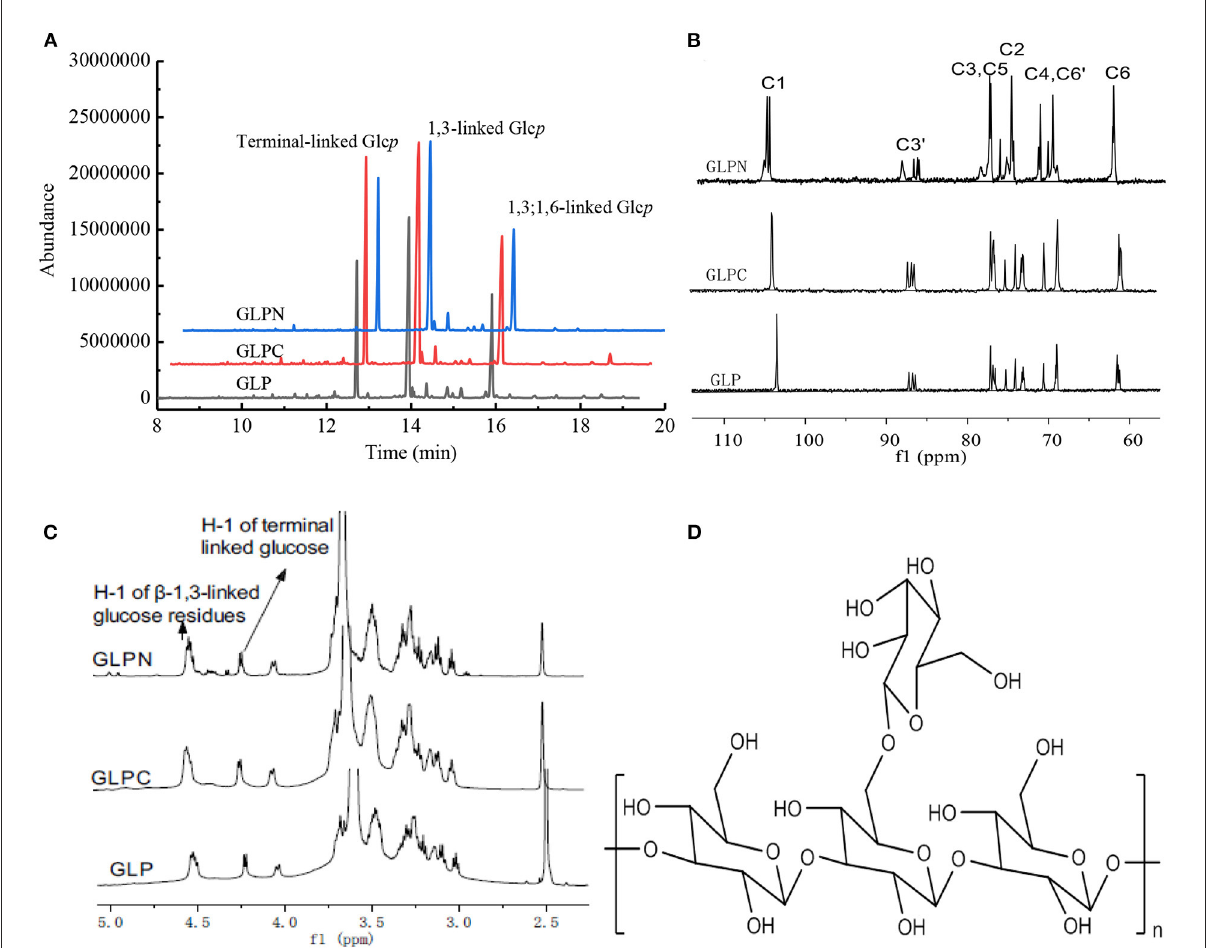
FIGURE3 Structure analysis of GLP, GLPC, and GLPN. (A) Total ion chromatogram of the methylated products of GLP, GLPC, and GLPN. (B) 13 C NMR spectra of GLP, GLPC, and GLPN. (C) 1 H NMR spectra of GLP, GLPC, and GLPN. (D) Primary repeat unit for GLP, GLPC, and